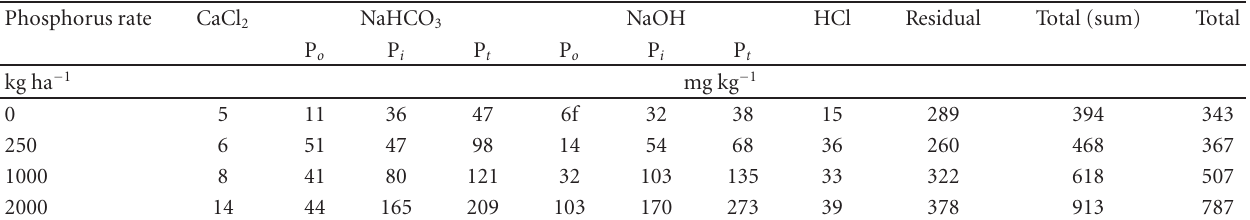
Table 4: Phosphorus fractions in a soil treated with increasing rates of